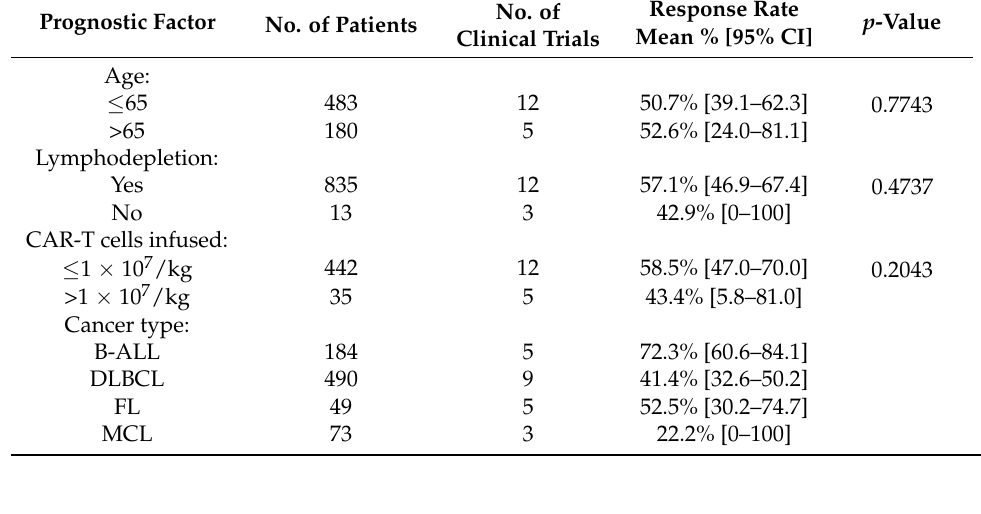
Table 2. Effect of prognostic factors on complete response rate.